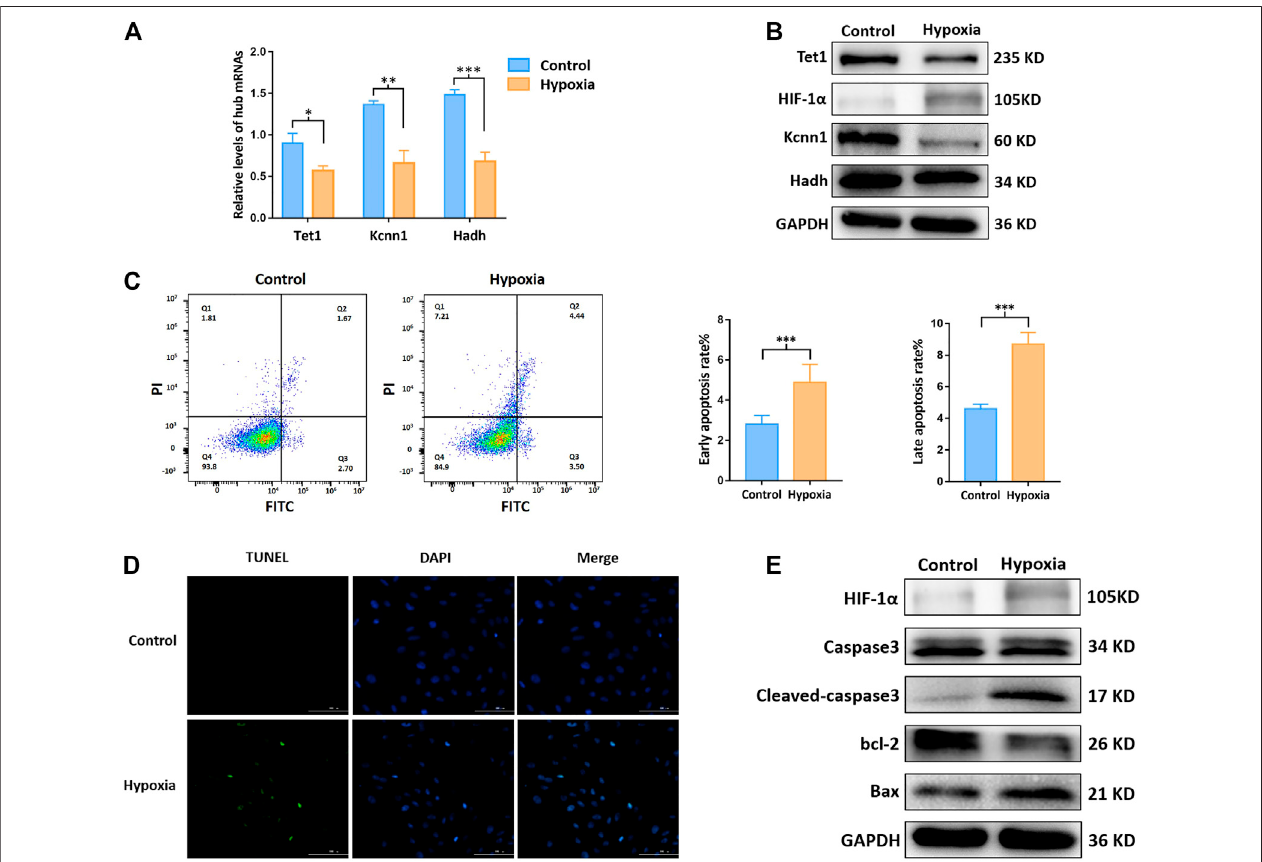
FIGURE 5 | m 6 A methylation regulated hub mRNAs play a role on apoptosis in vitro . (A) Expression of apoptosis related mRNAs by qRT-PCR; (B) protein level of Tet1,Kcnn1,andHadhbyWesternblot; (C) apoptosisrateby fl owcytometry; (D) apoptoticstatusbyTunelstaining; (E) proteinlevel(Caspase3,cleaved-caspase3,bcl- 2, Bax, and HIF-1 α ) by Western blot. * p < 0.05, ** p < 0.01, *** p <